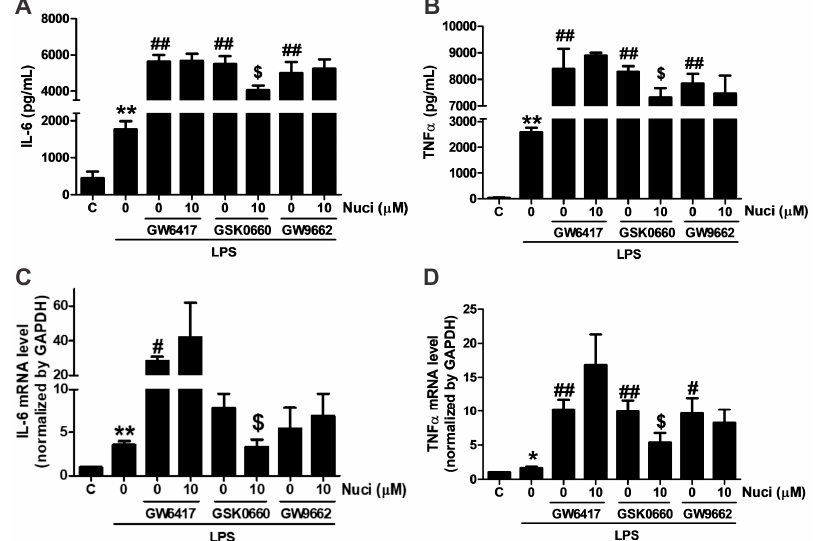
Figure 4. Antagonist of PPAR α and PPAR γ abolished the effects of nuciferine on the LPS-induced TNF α and IL-6 production. RAW264.7 cells were pretreated with GW6417/GSK0660/GW9662, for 12 h, followed by the nuciferine incubation, for 24 h, and then stimulated with LPS for 12 h. ( A , B ) production of the IL-6 and the TNF α in a cell medium supernatant. ( C , D ) mRNA expression of IL-6 and TNF α . * p < 0.05 ** p < 0.01 vs. control. # p < 0.05, ## p < 0.01 vs. LPS treatment. $ p < 0.05 vs.